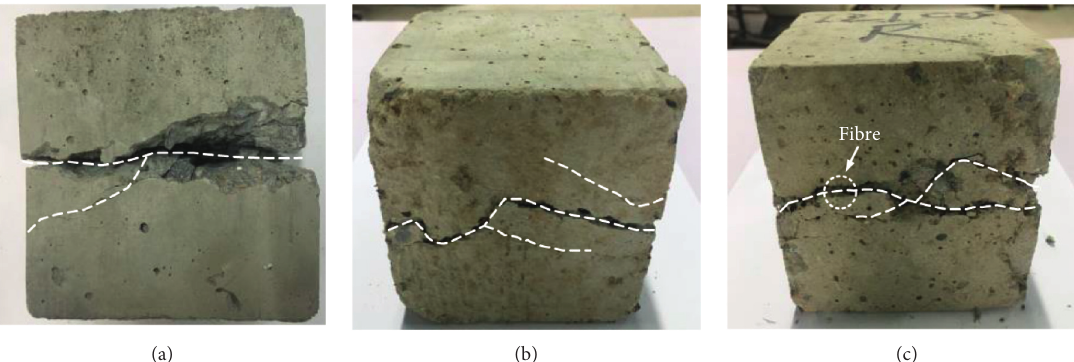
Figure 5: The influence of rubber particles and fibers on the shear failure mode of rubber fiber concrete. (a) C-0%-0%. (b) C-30%-0%. (c) C- 30%-0.6%.